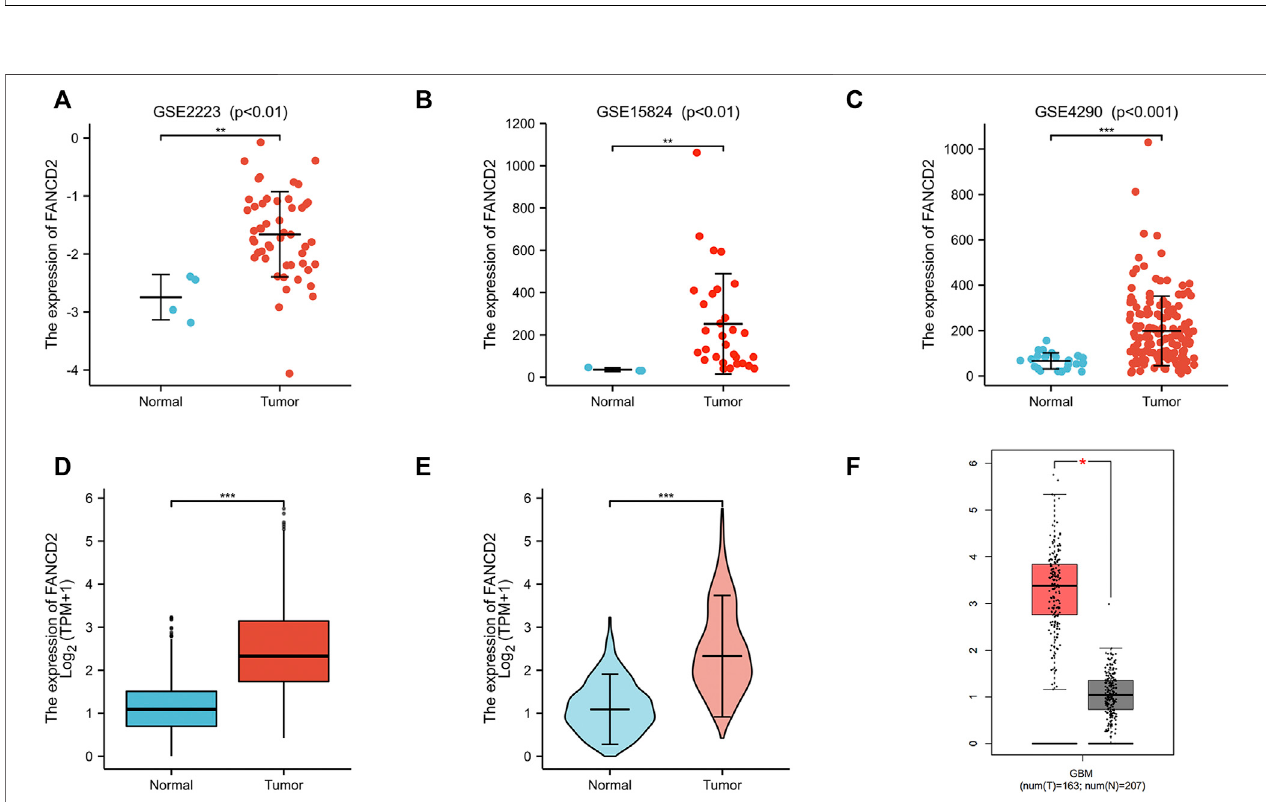
FIGURE3| The expression levelsofFANCD2 inGBM tissues (A – C) Comparedwithnormal brain tissues,FANCD2expression wassigni fi cantly increased inGBM tissues from three GEO datasets (D – E) The expression level of FANCD2 was up-regulated in the TCGA-GBMLGG cohort (F) GEPIA database indicated that FANCD2 expression was dramatically up-regulated in